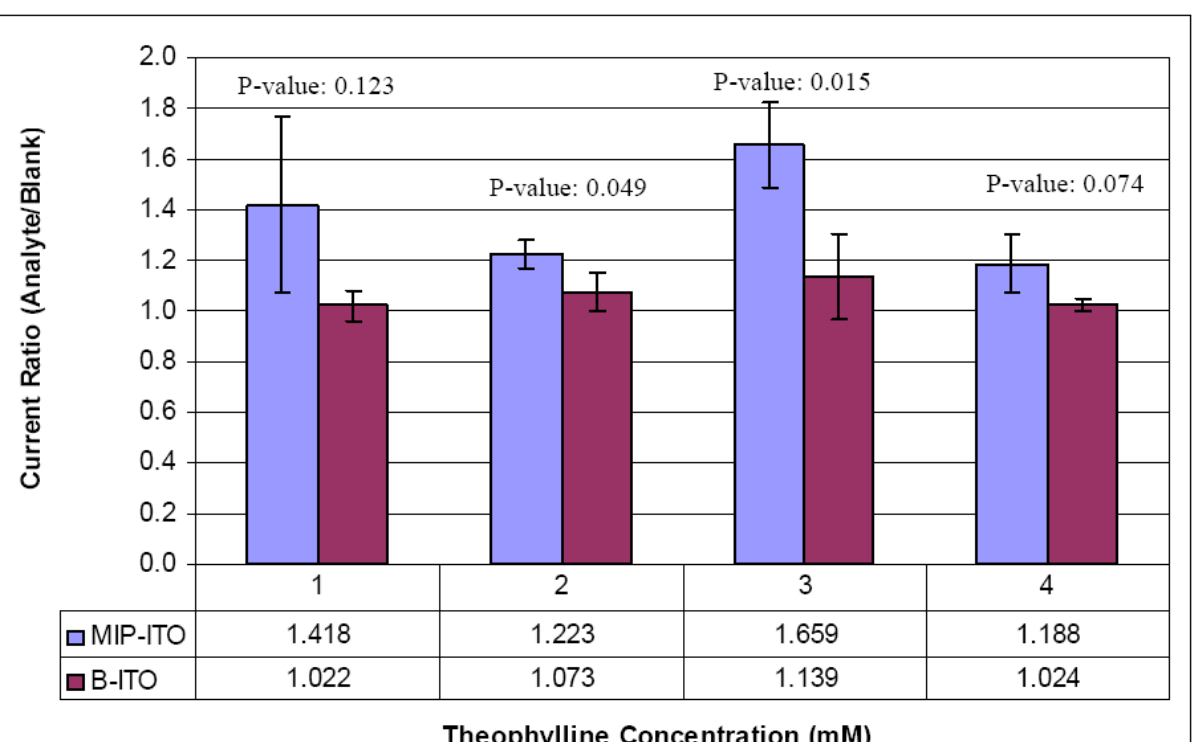
Figure 7. Comparison of the ratio of maximum currents of MIP-ITO sensor to B-ITO at various analyte